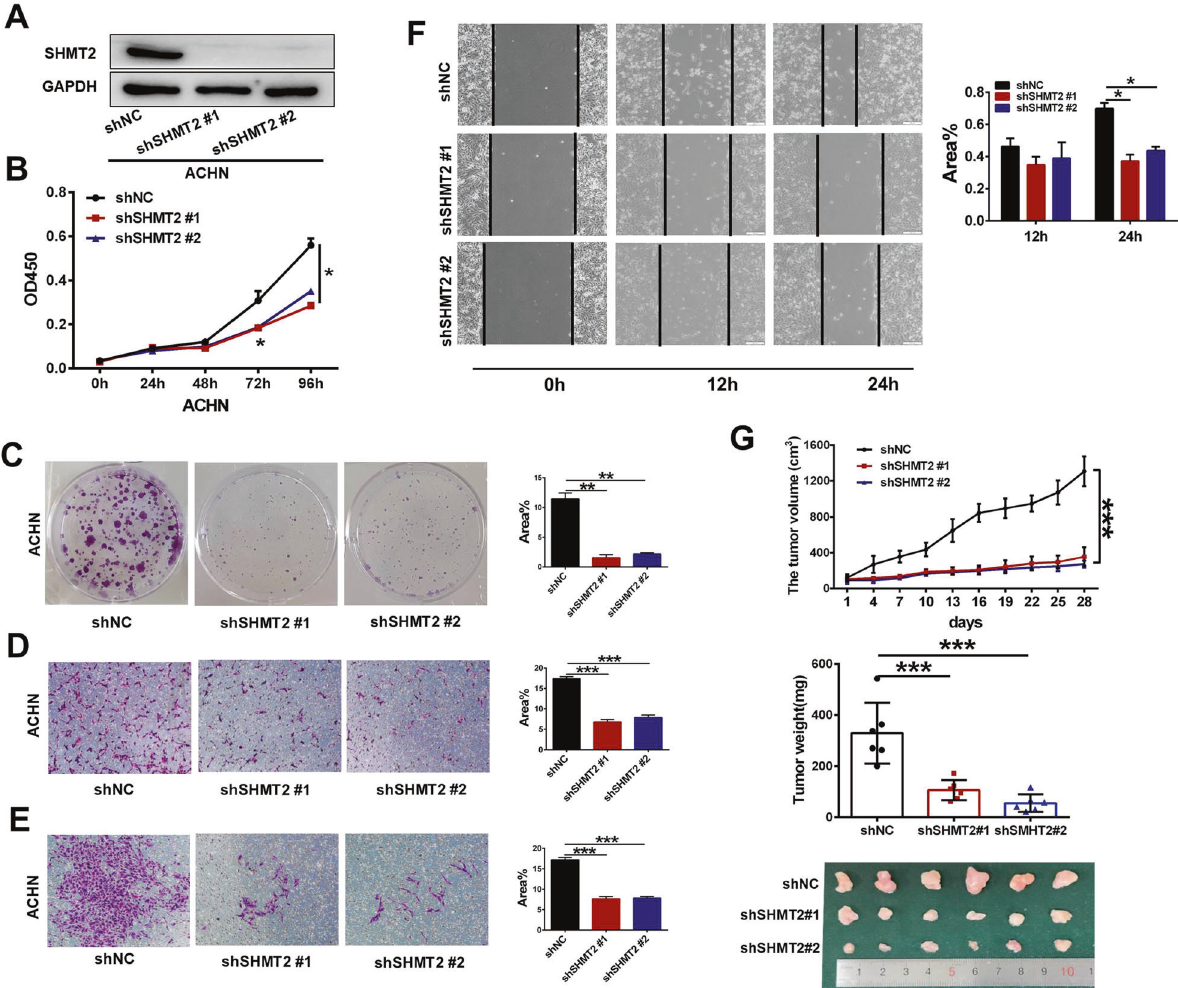
Fig. 2 Effects of stable SHMT2 knockdown on proliferation and metastasis in ccRCC cells. Lentivirus encoding scramble control shNC or targeted shSHMT2 vectors were infected into ACHN cells. A Western blot analysis was performed to evaluate SHMT2 protein levels in negative control (shNC) or shSHMT2 #1/#2 cells. B Cell proliferation assay of ACHN cells stably transfected with shNC or shSHMT2 #1/#2. Error bars represent SD ( n = 3). C Colony formation assays of ACHN cells stably transfected with shNC or shSHMT2 #1/#2 for 10 days. Each experiment was performed in triplicate. D, E Cell migration ( D ) and invasion ( E ) assays of ACHN cells stably transfected with shNC or shSHMT2 #1/#2. F Would healing assay of ACHN cells stably transfected with shNC or shSHMT2 #1/#2. G The tumor volume, weight, and images of shNC and shSHMT2 #1/#2 ACHN xenograft in nude mice. Tumor sizes were measured every 3 days for 4 weeks (top panel). Tumor weights were measured after dissection (middle panel). Tumor images were taken after dissection (bottom panel). Data were represented as mean ± SD. * P < 0.05, ** P < 0.01, *** P <